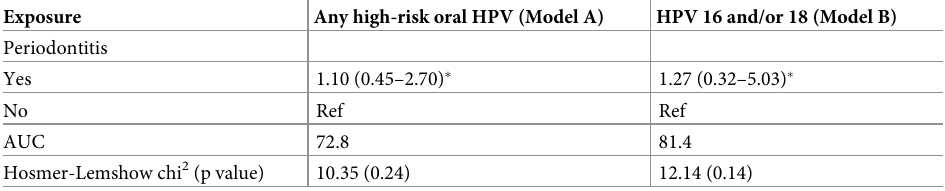
Table 4. Adjusted association between periodontitis and any high-risk oral HPV and HPV 16 and/or 18.